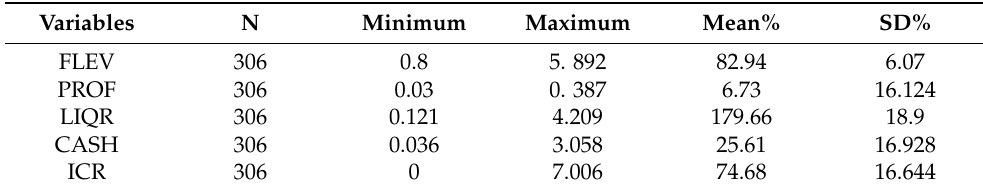
Table 5. Descriptive Analysis of Independent